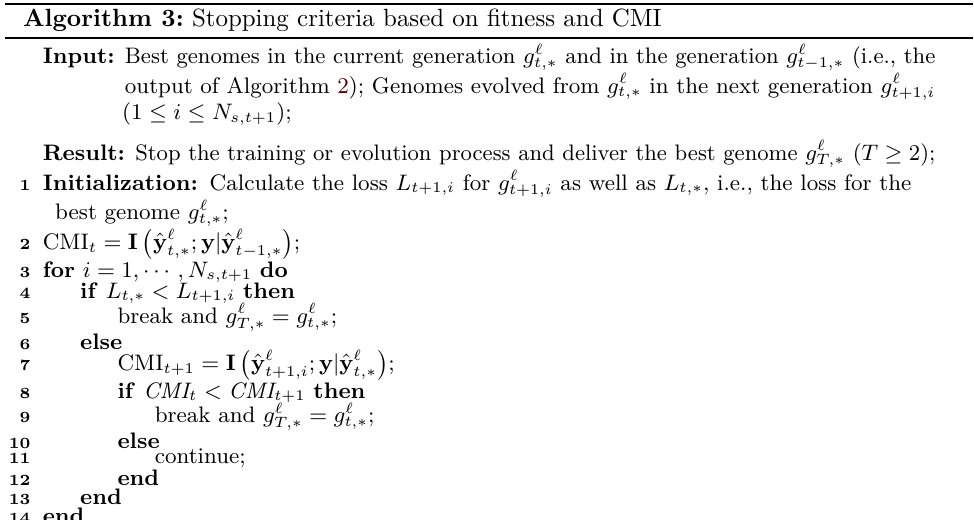
Algorithm 3: Stopping criteria based on fitness and